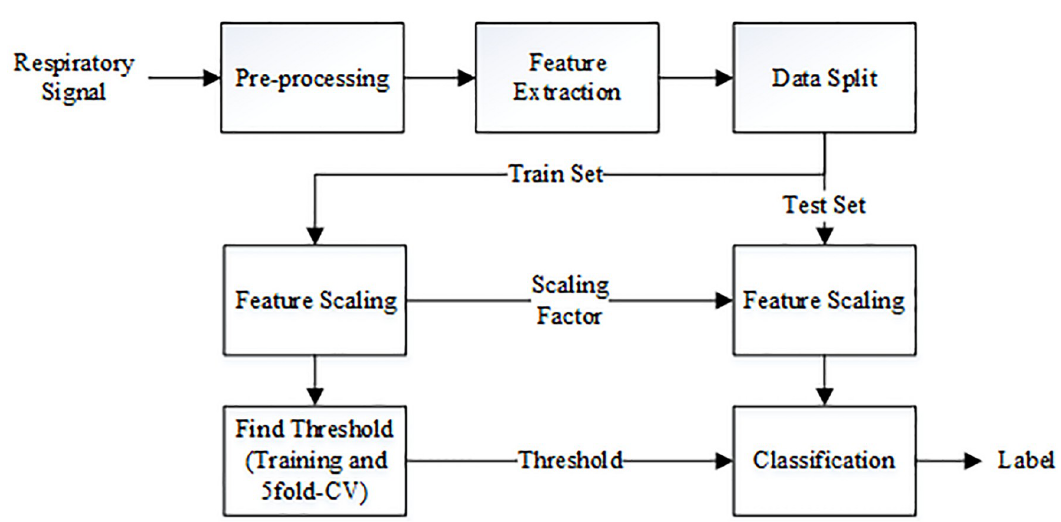
Fig 2. Flowchart for classification of wheeze and normal respiratory sounds using single